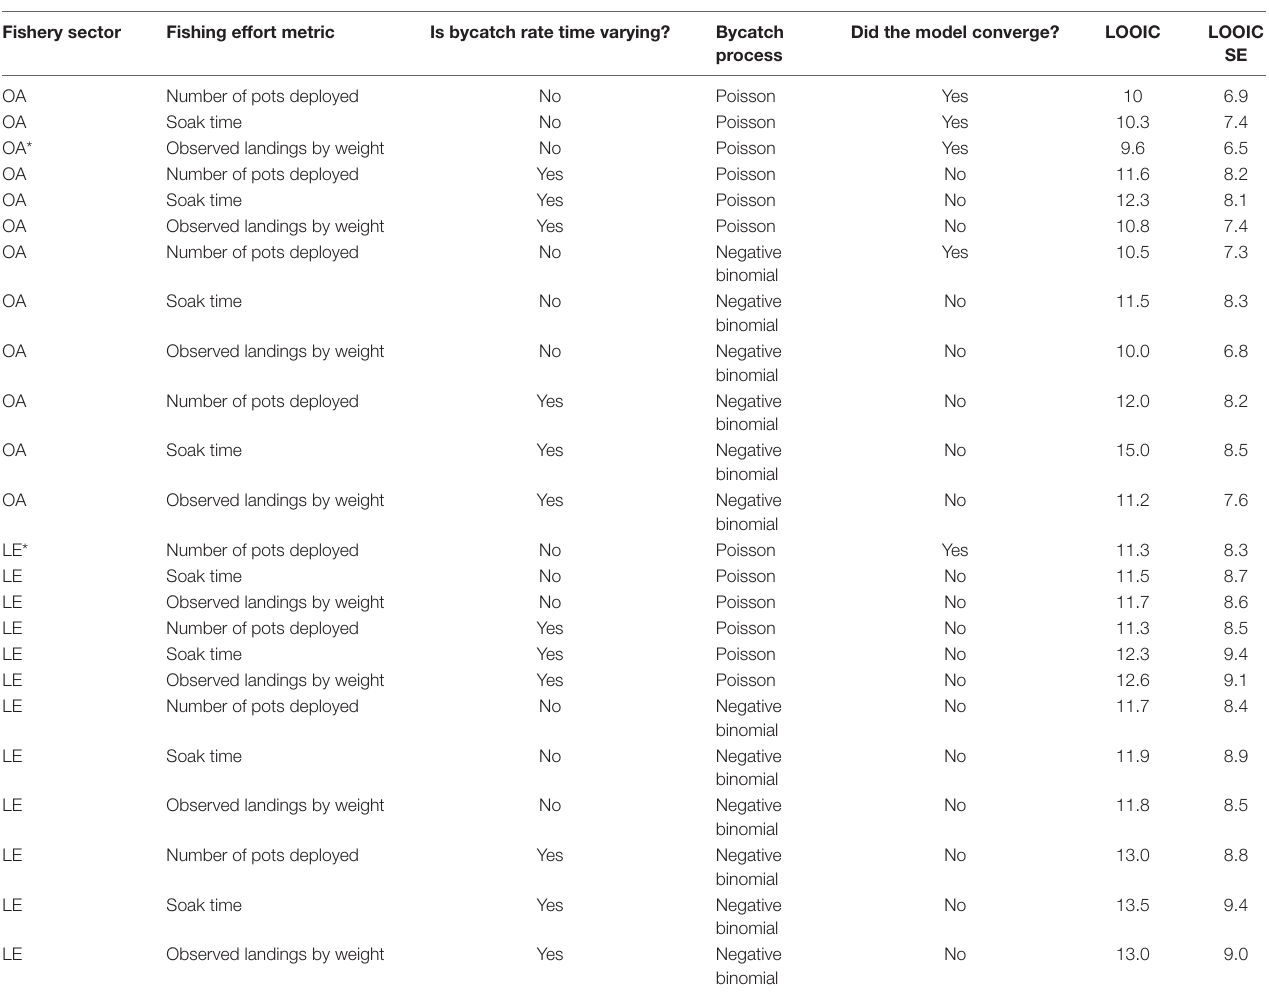
TABLE 1 | Model diagnostics [convergence, LOOIC, and LOOIC standard error (SE)] by fishery sector for each fishing effort metric, time-varying, and bycatch process model choice. Asterisk (*) indicates the model that both converged and had the lowest LOOIC. Fishery sector Fishing effort metric Is bycatch rate time varying? Did the model